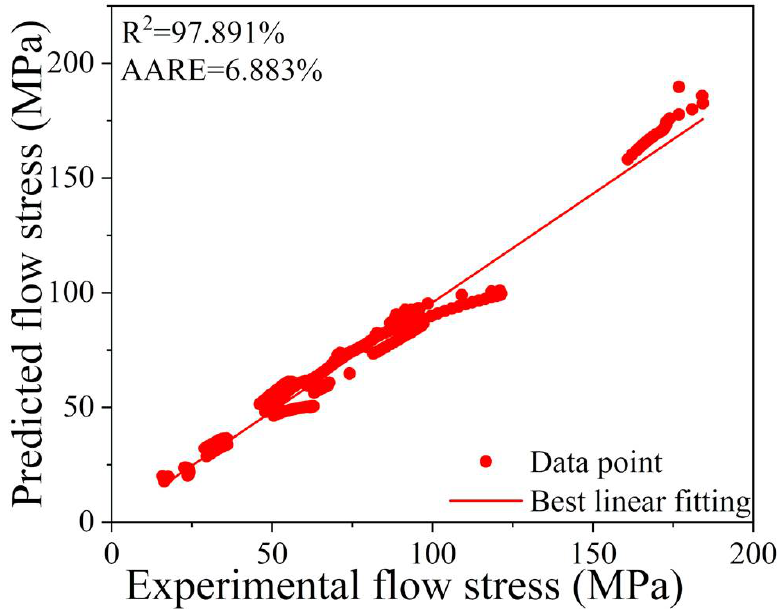
Figure 10. Fitting relationship between experimental and predicted flow stress.